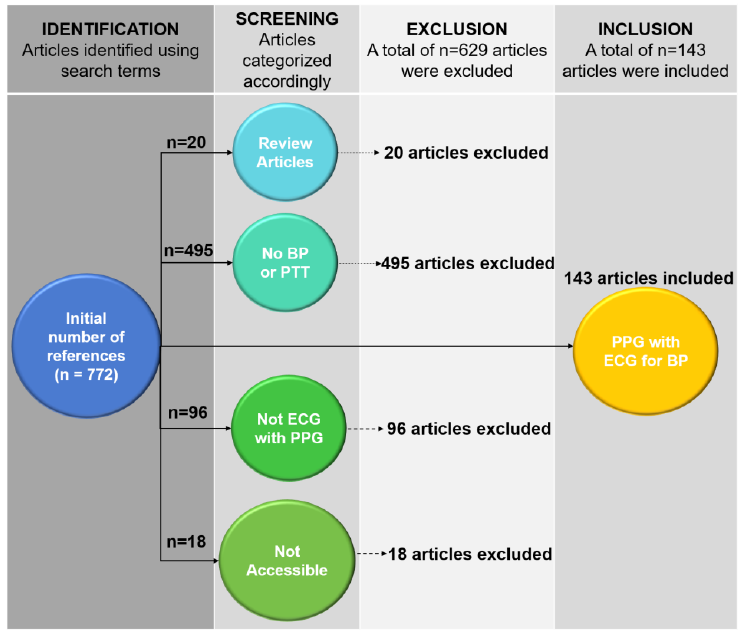
Figure 2. Flowchart of the methodology used to include 143 out of 772 published